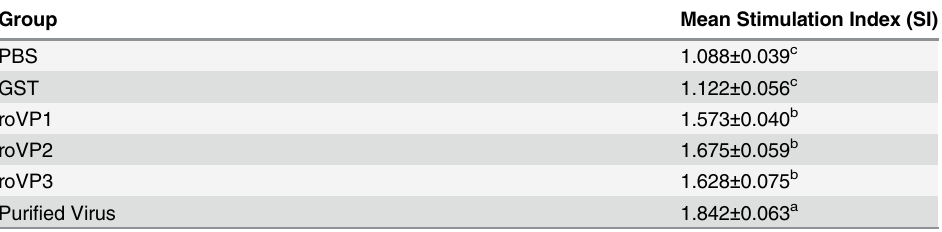
Table 3. Lymphocyte proliferation responses in different immunized and control groups.